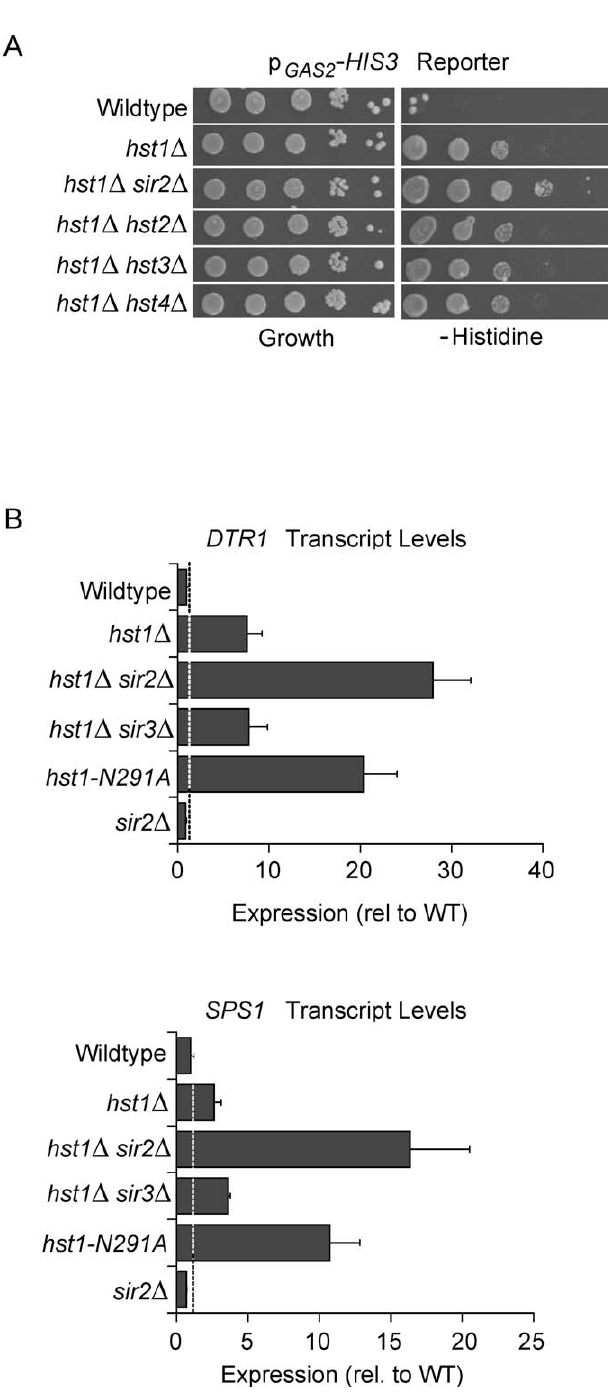
Figure 1. Sir2p Contributes to Repression of Sum1p-Repressed Genes in the Absence of Hst1p (A) Expression of the Sum1p-repressed p GAS2 -HIS3 reporter was tested in wild-type (LRY1453) , hst1 D (LRY1454) , hst1 D sir2 D (LRY1422) , hst1 D hst2 D (LRY1686), hst1 D hst3 D (LRY1704), and hst1 D hst4 D (LRY1687) strain backgrounds. A ten-fold dilution series of each strain was plated on rich medium (growth) or medium lacking histidine ( (cid:2) histidine) and photo- graphed after 3 d of growth at 30 8 C. The most concentrated samples